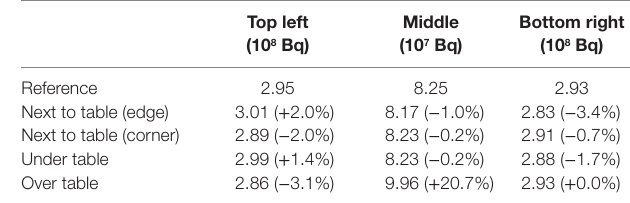
TaBle 1 | Overview of the determined point-source FWhMs and the standard deviations of the inhale peak time differences. Motion shape sinusoidal cosine 4 cosine 4 cosine 4